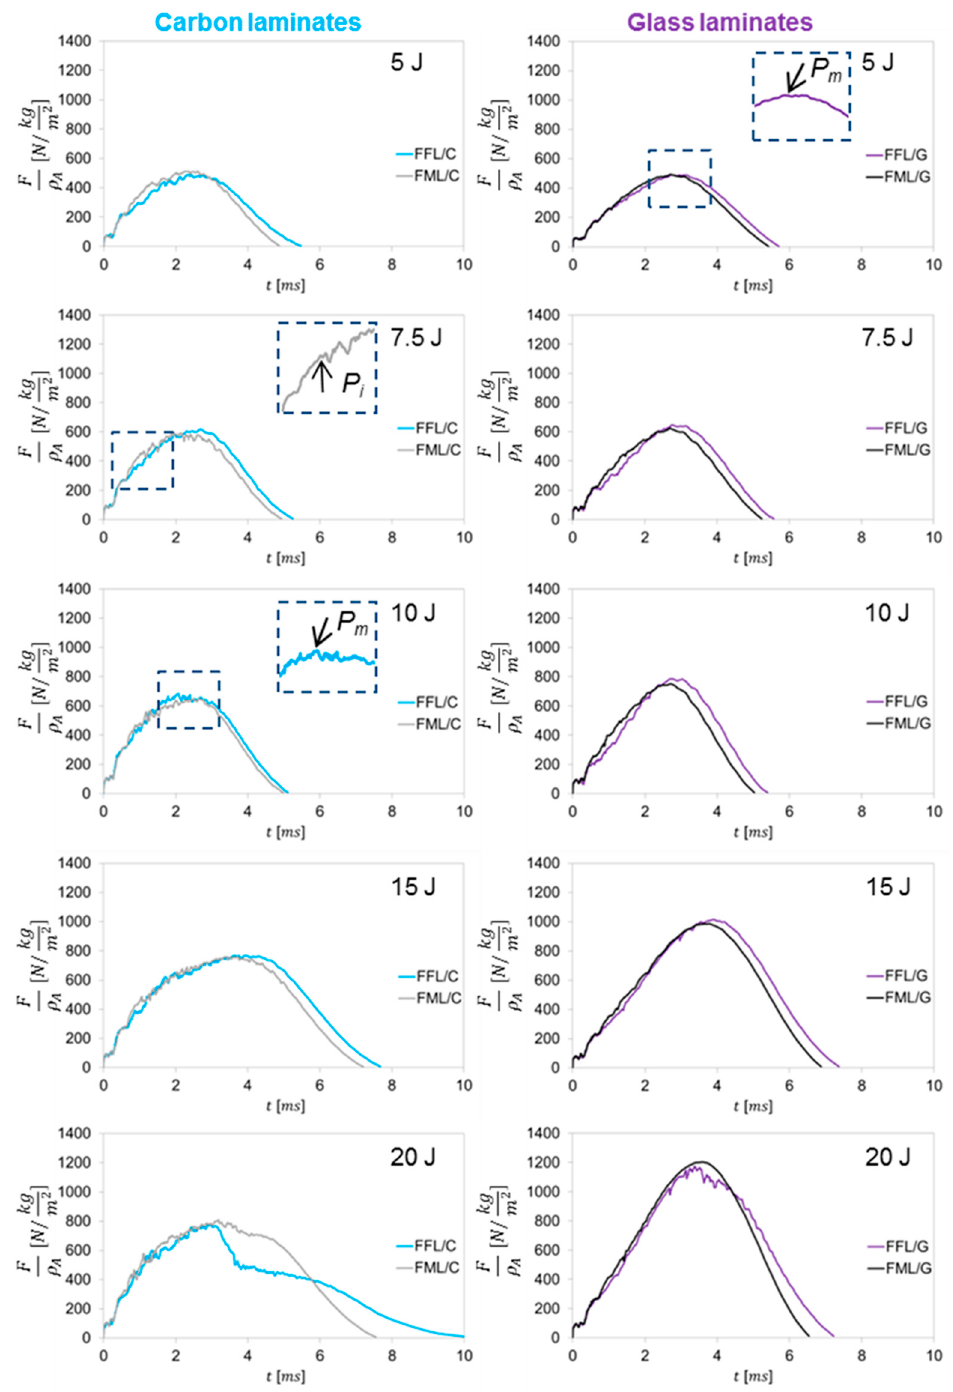
Figure 2. Force–time curves of FFLs and FMLs laminates after low–velocity impact in range of 5–20 J. In terms of contact time between the specimen and the impactor tip, some differences were observed. It was noticed that fibre foam laminates interact with the intender for a longer time than fibre metal laminates. This difference was on average 12.3% for FFL/C laminates and 7.3% for FFL/G in comparison to FML/C and FML/G. The FFLs with a lower areal density and hence lower inertia produce a more efficient distribution of the stress during the impact. On the other hand, the FMLs, with a lower contact time, may be characterized by a better ability to return the laminate to the elastic range